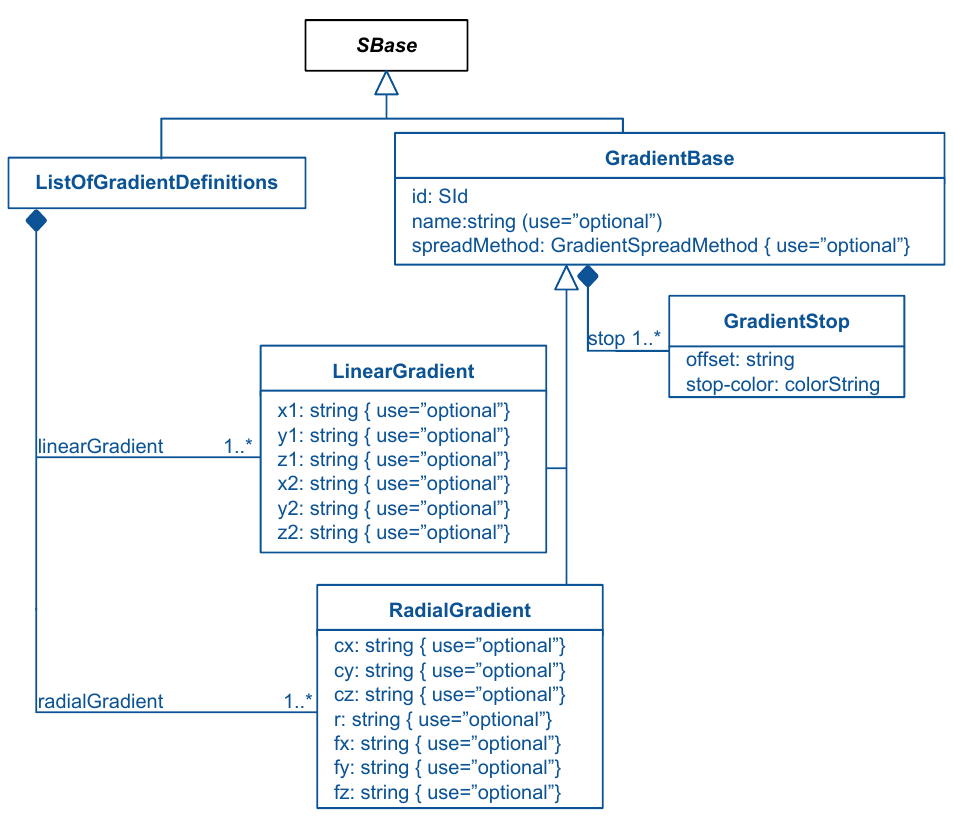
Figure 7: A UML representation of the gradient objects for the Render package. See Section 1.4 for conventions related to this figure.